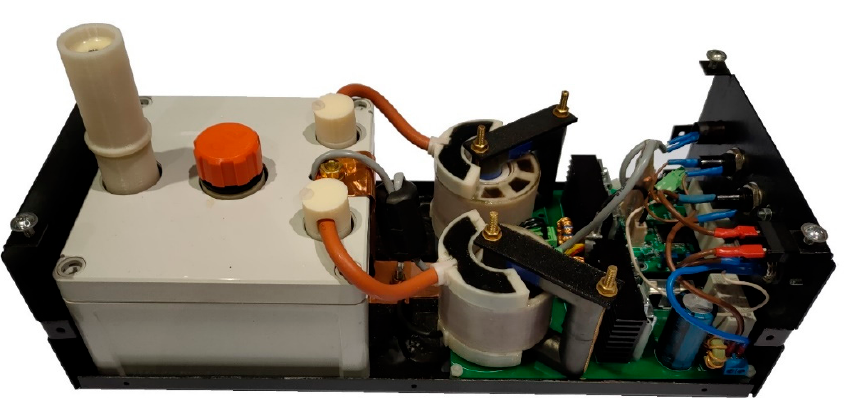
Figure 12. Photo of the high voltage power supply finalized prototype interior.